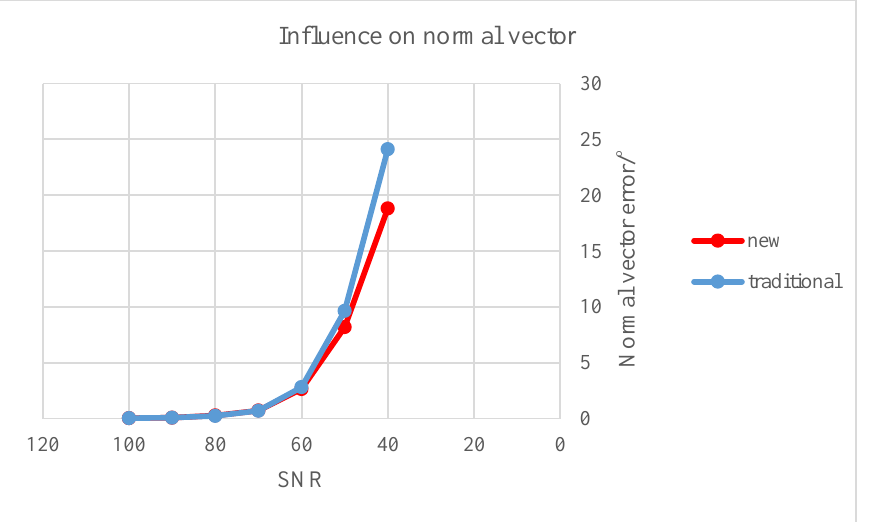
Figure 8. Influence of the elliptical edge on the normal vector of the space circular target. Table 6. Influence of the elliptical edge on space circular target parameters.